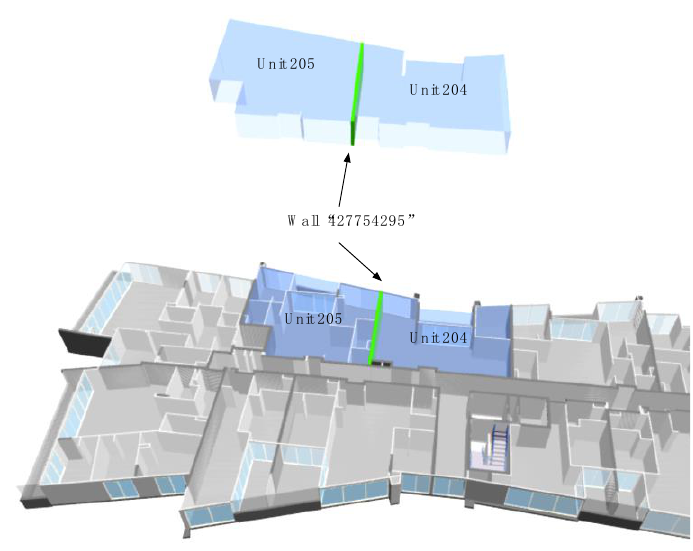
Figure 9. Query results for the related legal spaces of a building Figure 8. Query results for the related legal spaces of a building element.